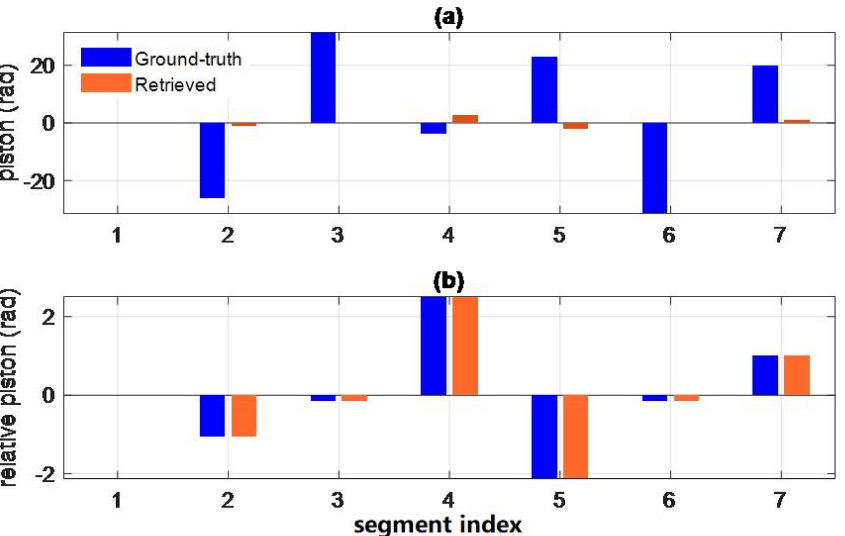
Figure 9. Large piston retrieval: ( a ) the retrieved piston vs. the ground truth piston and ( b ) the retrieved relative piston vs. the relative ground truth piston. In ( b ), the first segment is set as the reference, and the relative piston is